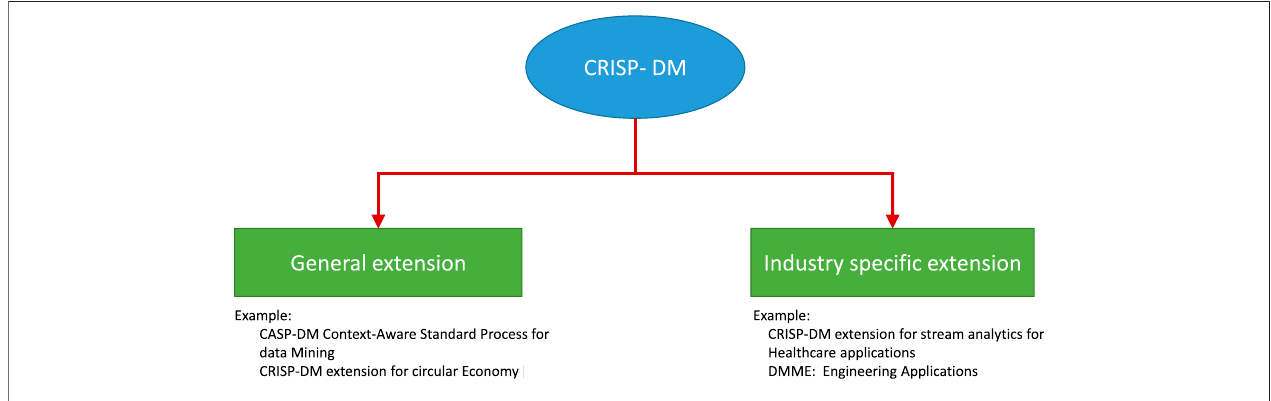
FIGURE 2 | Classi fi cation of the CRISP-DM framework into two categories: general extensions and industry-speci fi c extensions.